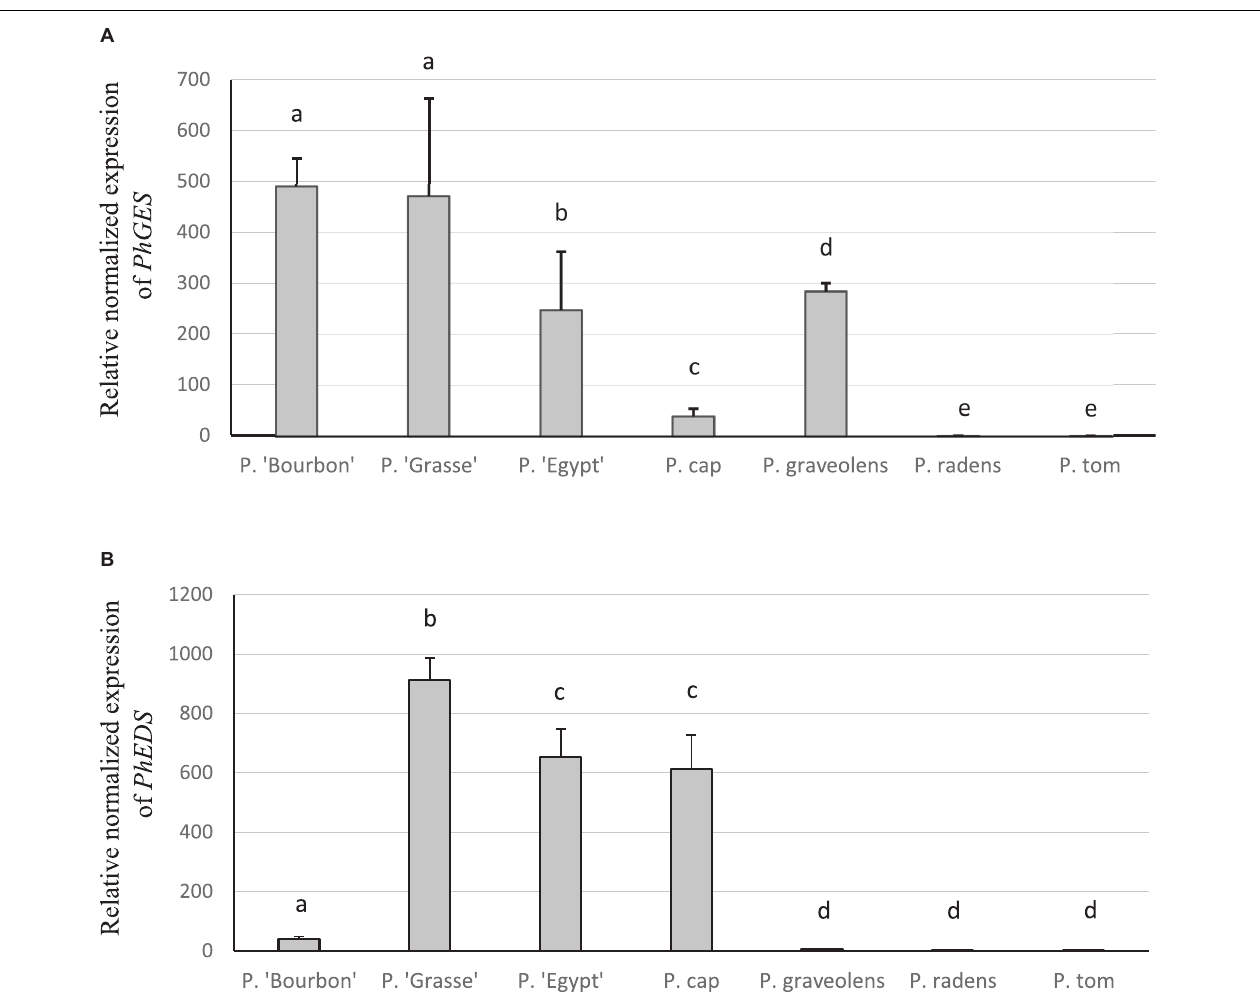
FIGURE 7 | Transcriptional activity of PhGES (A) and PhEDS (B) in several pelargonium species. TPS transcript levels were normalised to b -actin and tubulin then to the expression level of P. tomentosum . Error bars indicate standard deviation with n = 4. Statistical analyses were performed with the software REST. Same letter indicates no statistical differences with a p -value <